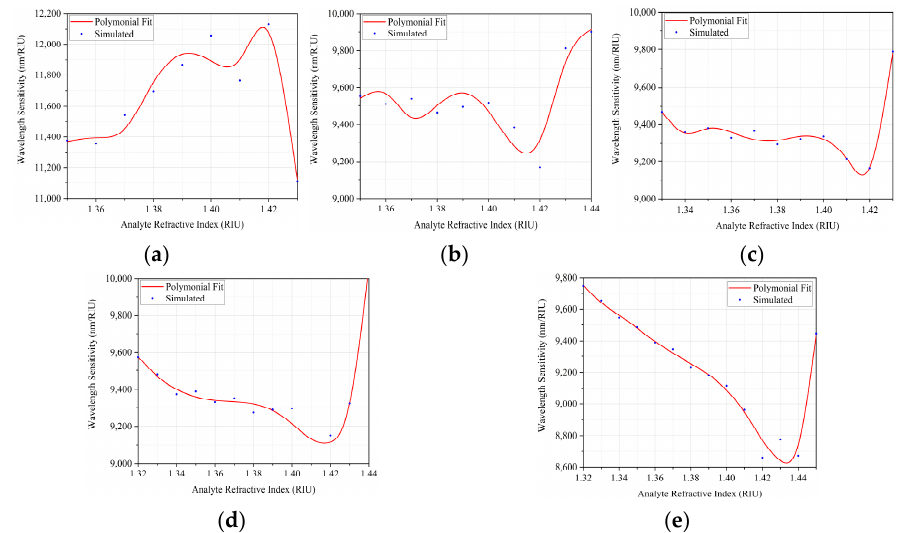
Figure 11. Adjustment of curves for the sensitivity values obtained: ( a ) Defect without doping; ( b ) Doping with GeO 2 ( 4.1% ) ; ( c ) Doping with GeO 2 ( 6.3% ) ; ( d ) Doping with GeO 2 ( 13.5% ) ; ( e ) Doping with GeO 2 ( 19.3% ) .